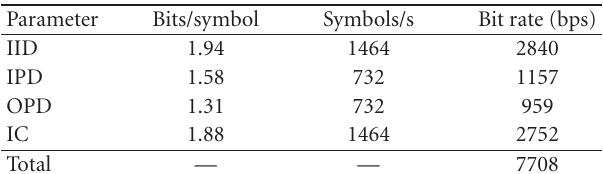
Table 1: Entropy per parameter symbol, number of symbols per second, and bit rate for spatial